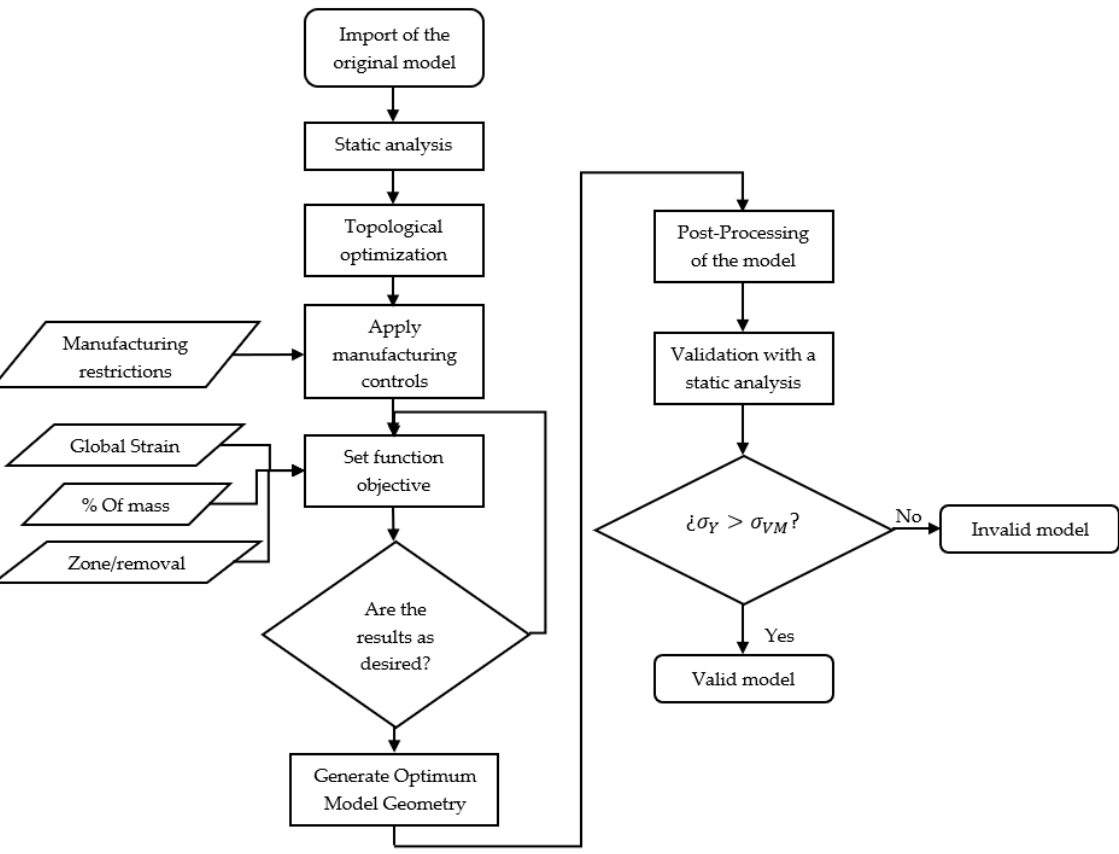
Figure 8. The methodology used to optimize parts.